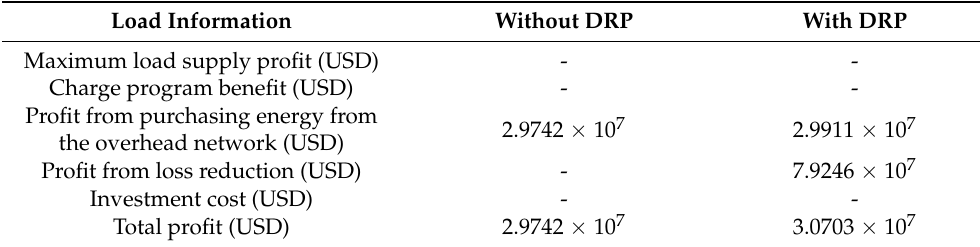
Table 4. Simulation results for the location of an electric vehicle park.